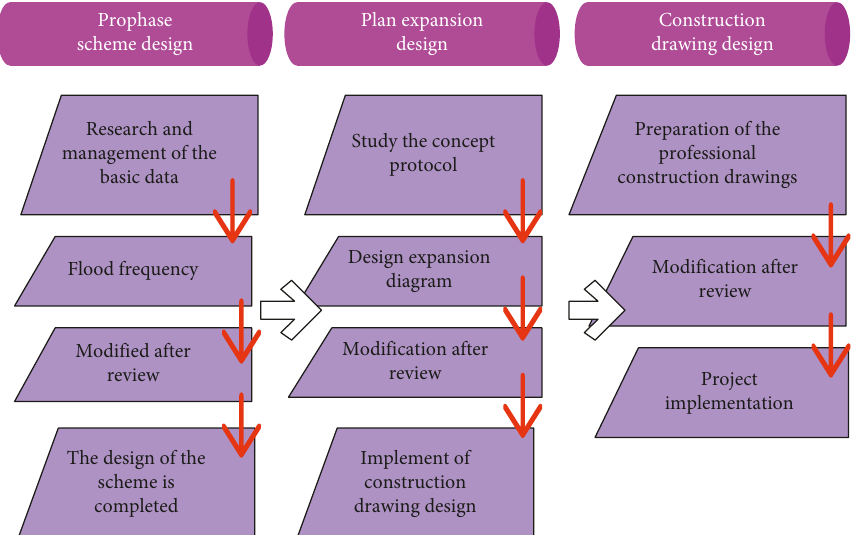
Figure 3: Design process of sustainable development garden landscape